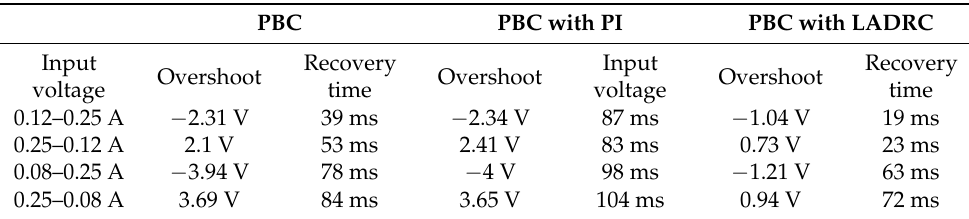
Figure 20. The dynamic response during v 2 step in step-up mode (36 – 60 V): ( a ) PBC; ( b ) PBC with PI; ( c ) PBC with LADRC. When i 1 jumps between 0.08 and 0.25, the data for dynamic performance are shown in Table 3. Table 4. The dynamic performance comparison during the v 2 step in step-up mode.